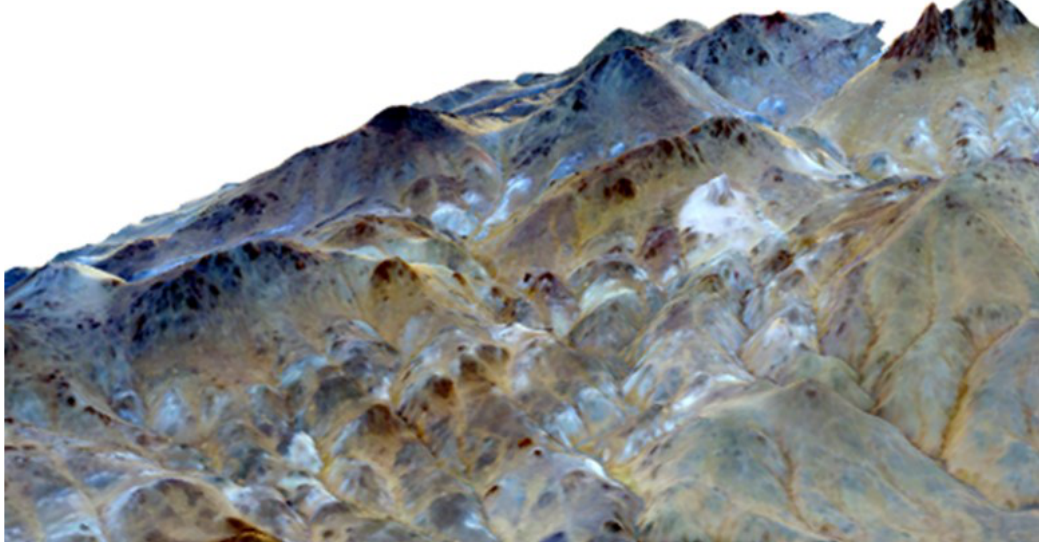
Fig. 7. Overlapping of orthomosaic and DEM